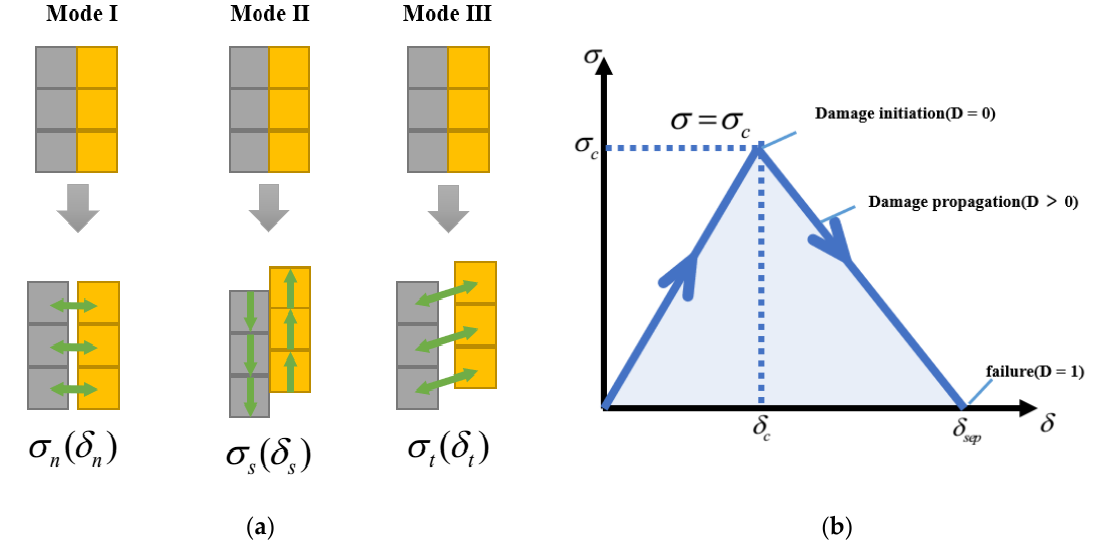
Figure 6. Cohesive zone damage; ( a ) Traction separations for different fracture modes; ( b ) Typical bilinear traction separation behavior.